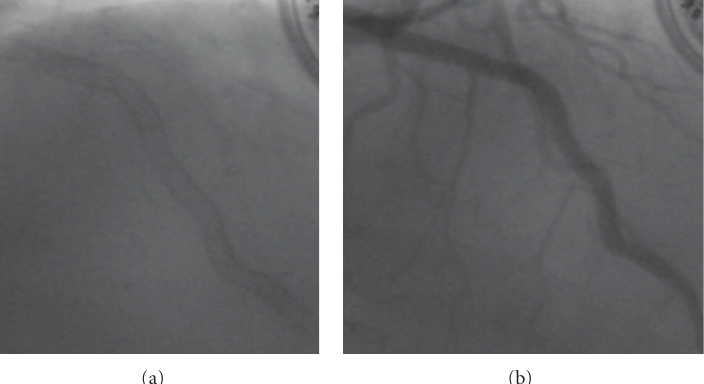
Figure 5: Angiographic images of the left anterior descending artery after two Endeavor stents deployment showing the absence of stent strut separation (a) and the presence of a good angiographic result (b).